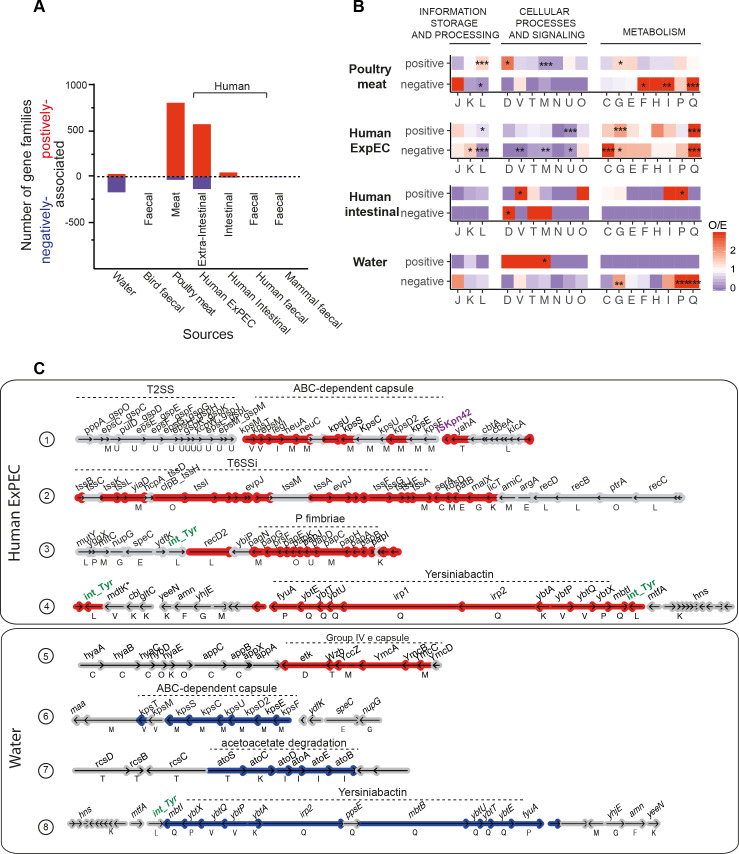
Genetic determinants of each isolation source.A. Number of gene families positively (in red) and negatively (in blue) associated with each source. B. Observed/expected (O/E) ratios of non-supervised orthologous groups (NOGs, shown as capitalized letters, same as in Fig 1C) in the positively or negatively associated gene families. The ratio (O/E) was reported for all comparisons with a color code ranging from blue (under-representation) to red (over-representation). The level of significance of each Fisher’s exact test was indicated (P> = 0.05: ns; P<0.05: *; P<0.01: **; P<0.001: ***). It was performed on each 2*2 contingency table. Only gene families with known functions were considered in this analysis. Gene families lacking matches to the EggNOG functional categories were discarded.C. Genomic organization of regions enriched in genes strongly positively (in red) or negatively (in blue) associated with a source. Genes shown in grey are not significantly associated. The name of the gene (when available) is shown above it, its functional category (when known) below it.